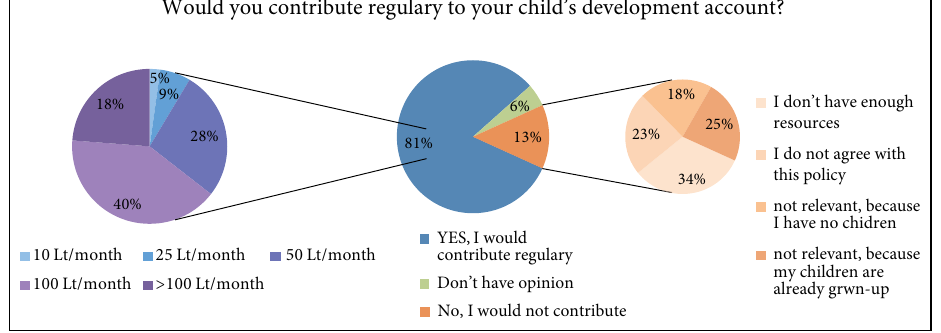
Fig. 11. Respondents’ opinion towards personal contributions to the CDA (authorial computation, according to the survey